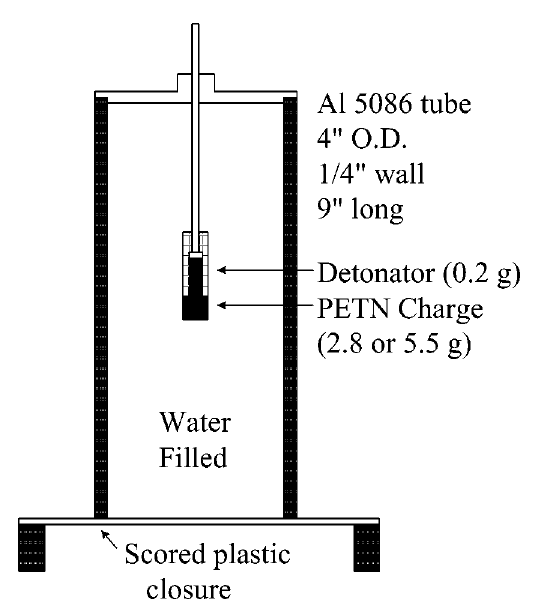
Fig. 1. Experimental